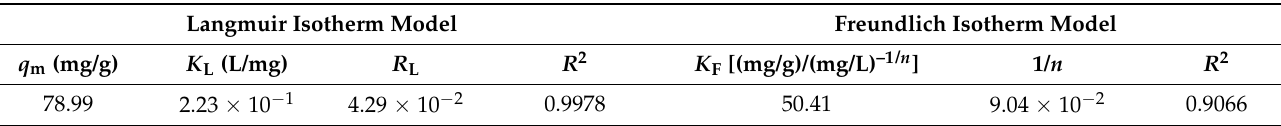
Table 2. Langmuir and Freundlich isotherm constants for Cu(II) adsorption onto G1H20 nanoparticles at a pH of 6 and 60 ◦